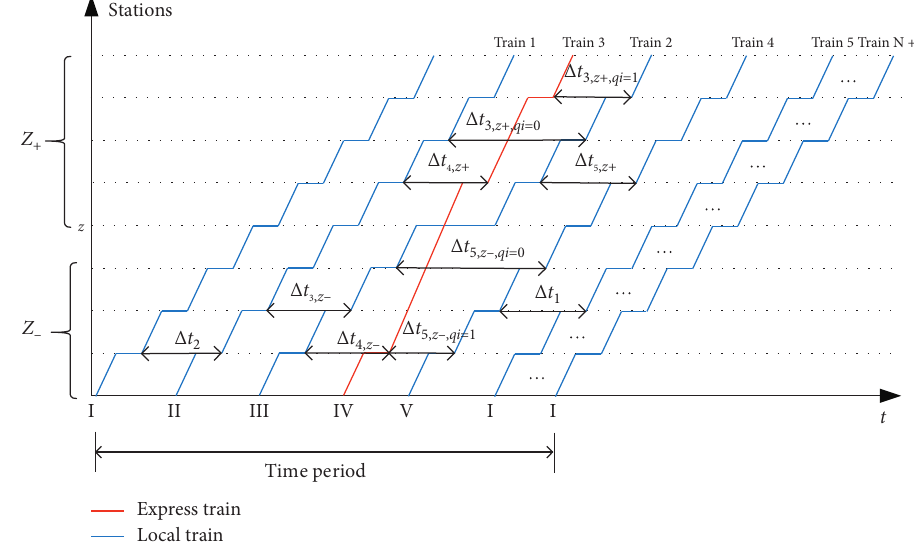
Figure 6: Illustration for different departure intervals in a